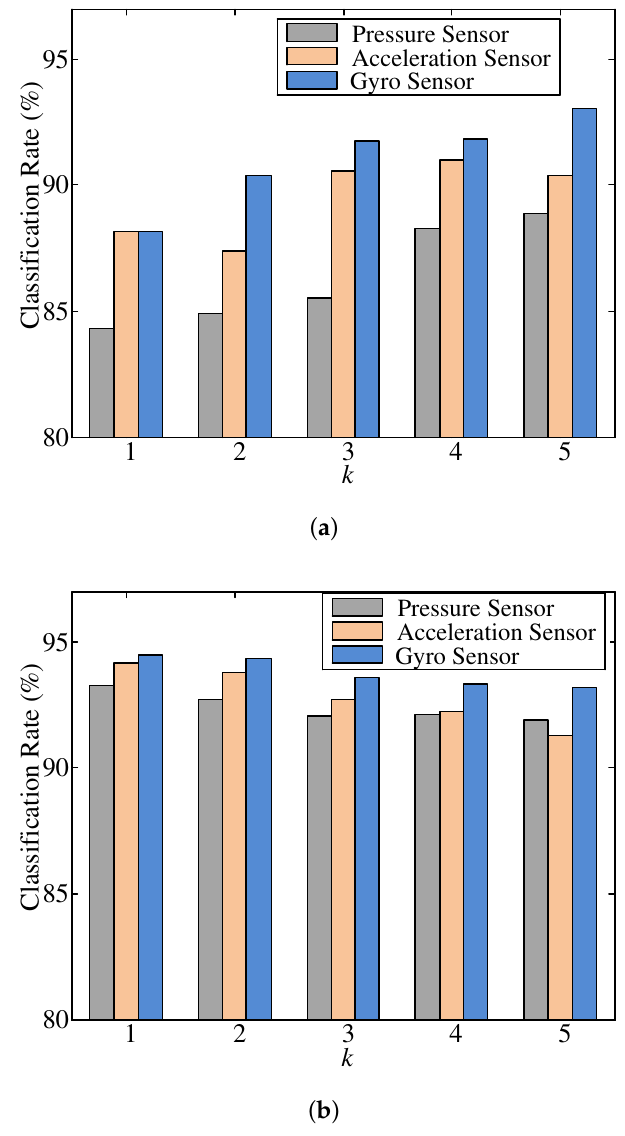
Figure 9. Classification rates of single-modal DCNNs for various k . ( a ) randomly selected 1000 training data samples and 1000 test data samples; ( b ) 7-fold cross